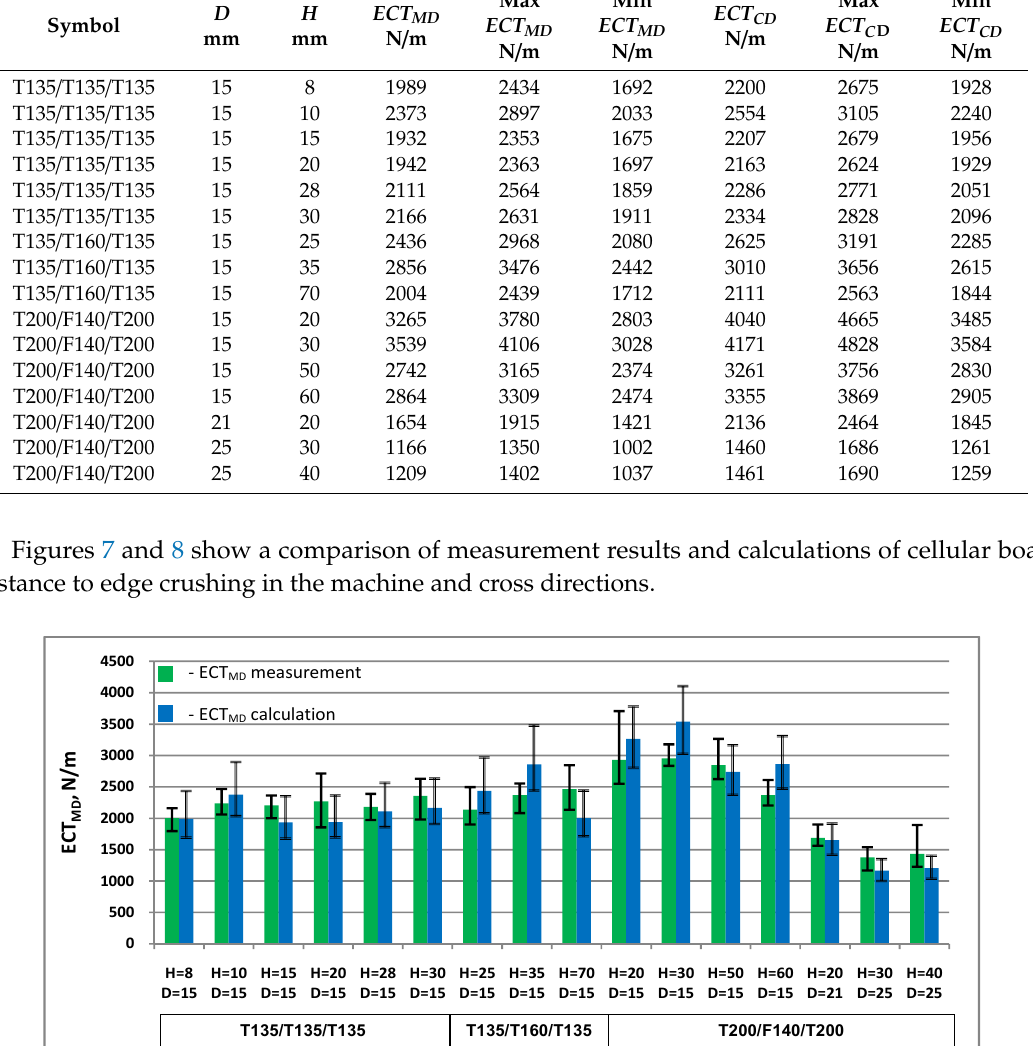
Figure 8. Resistance of honeycomb paperboard to edge crushing in the cross direction.